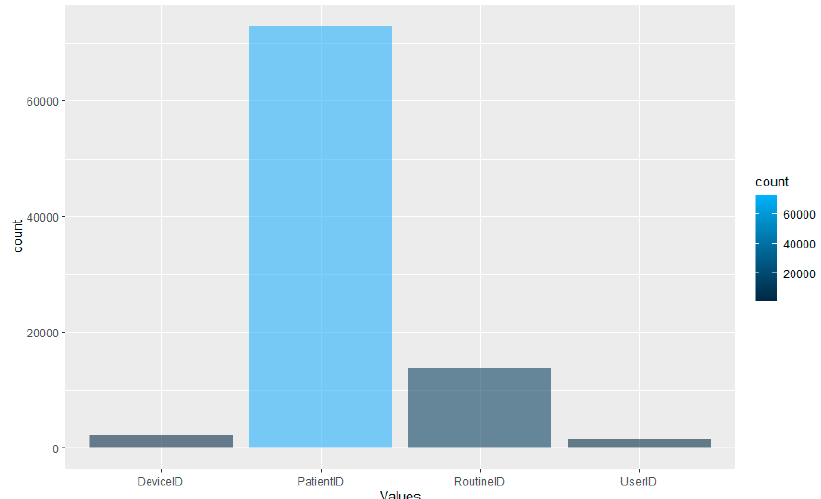
Figure 5. Dataset Figure 5. Dataset balance.